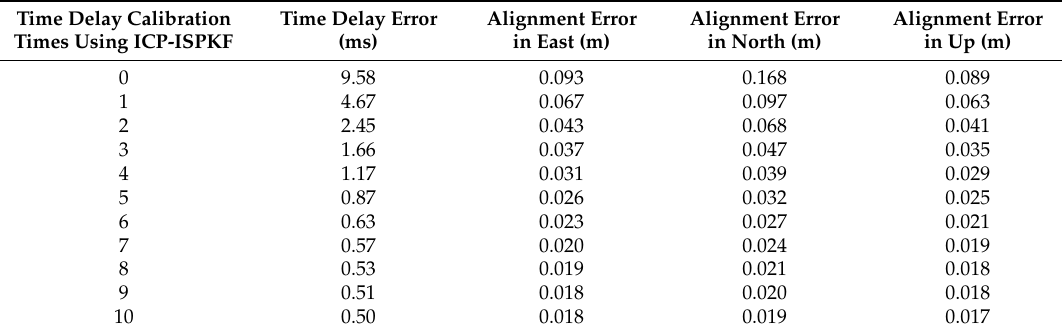
Table 2. Time delay calibration times using ICP-ISPKF for